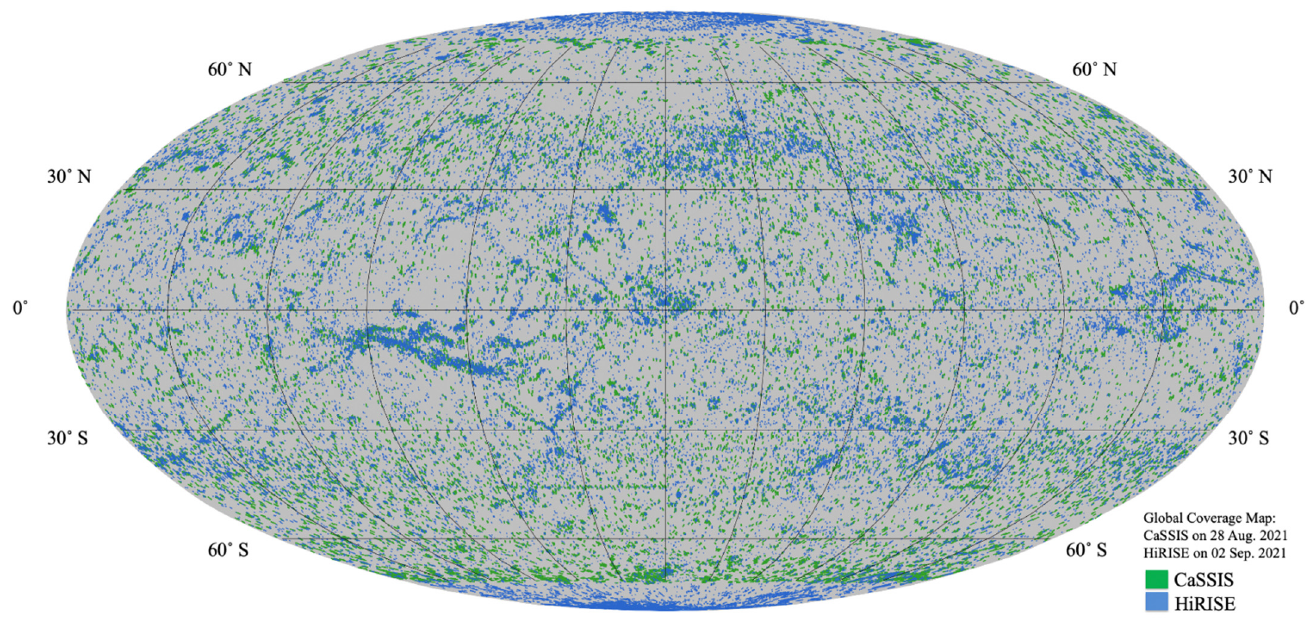
Figure 1. Global coverage of CaSSIS in green (up to 28 August 2021) and HiRISE in blue (up to 2 September 2021) images of Mars (map projection: Mollweide).